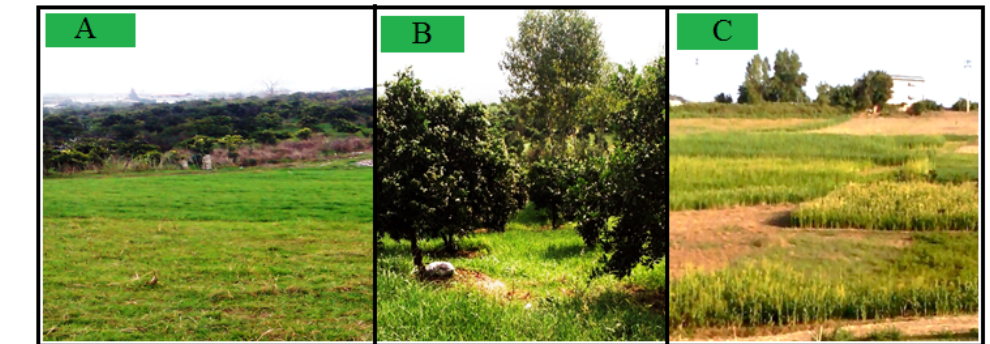
Fig. 1: Study area and sampling sites in different land uses in Mazandaran Province, northern Iran